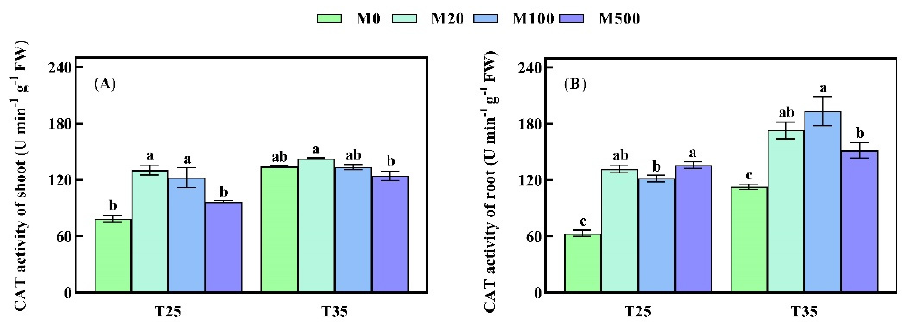
Figure 4. Effects of exogenous melatonin on the CAT activity of rice seed shoots and roots under drought stress. Means ± SEs with different letters in each parameter indicate significant statistical differences (LSD, 0.05). ( A ) CAT activity of shoot; ( B ) CAT activity of root.